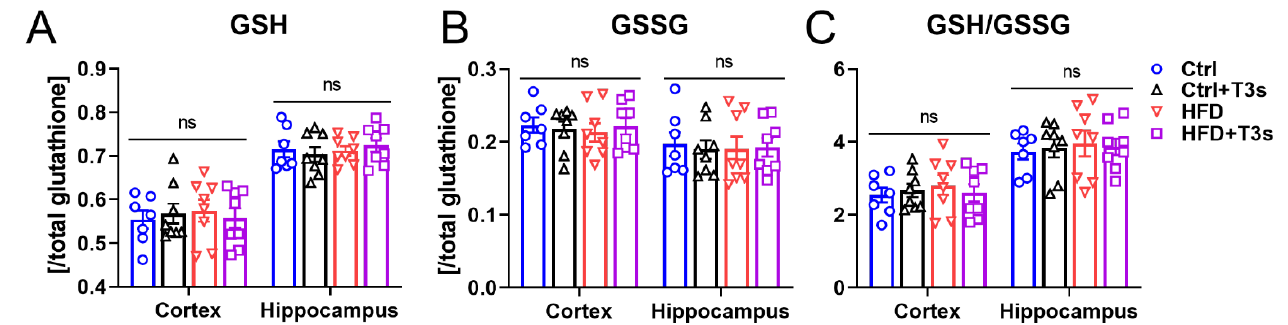
Figure 4. Brain oxidation levels. ( A , B ) GSH and GSSG levels in each mouse brain. (Ctrl, n = 7; Ctrl + T3s, HFD and HFD + T3s, n = 8). ( C ) Ratio of GSH and GSSG. (Ctrl, n = 7; Ctrl + T3s, HFD and HFD + T3s, n = 8).